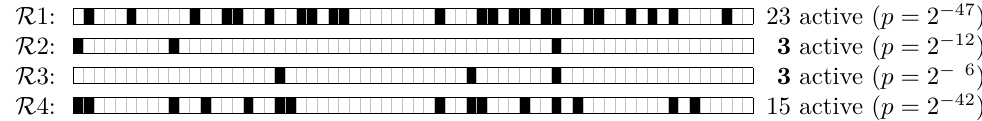
Figure 3: Best known differential 4-round characteristic with 44 active S-boxes [DEMS21a]. For a characteristic with ≤ B active S-boxes for R rounds, the maximum possible girdle weight is S max = b B/R c . Thus, the total number of potential girdle patterns